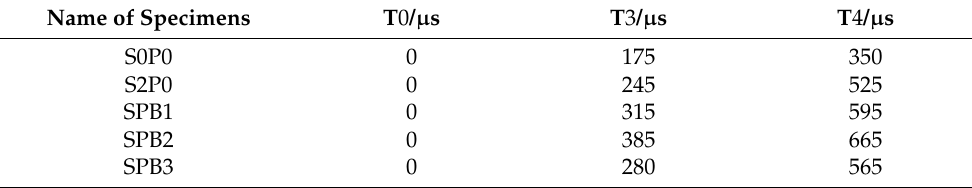
fiber group was improved. Table 9. Corresponding schedule of crack failure form in each